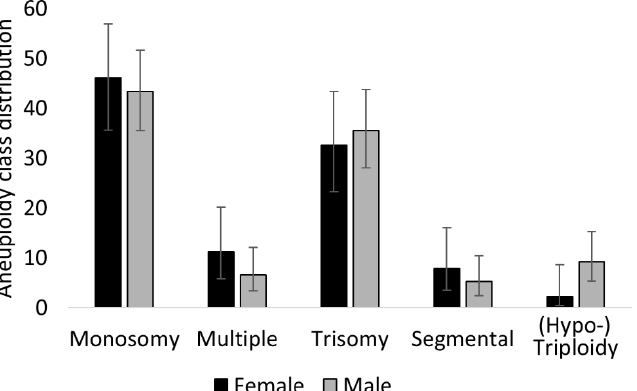
Figure 4. Relationship between embryo sex and aneuploidy. Although, overall, aneuploidy incidence was higher in XY embryos as compared to XX embryos, the different aneuploidy classes were equally distributed between them. Data presented as percentage (%) with 95% CI.